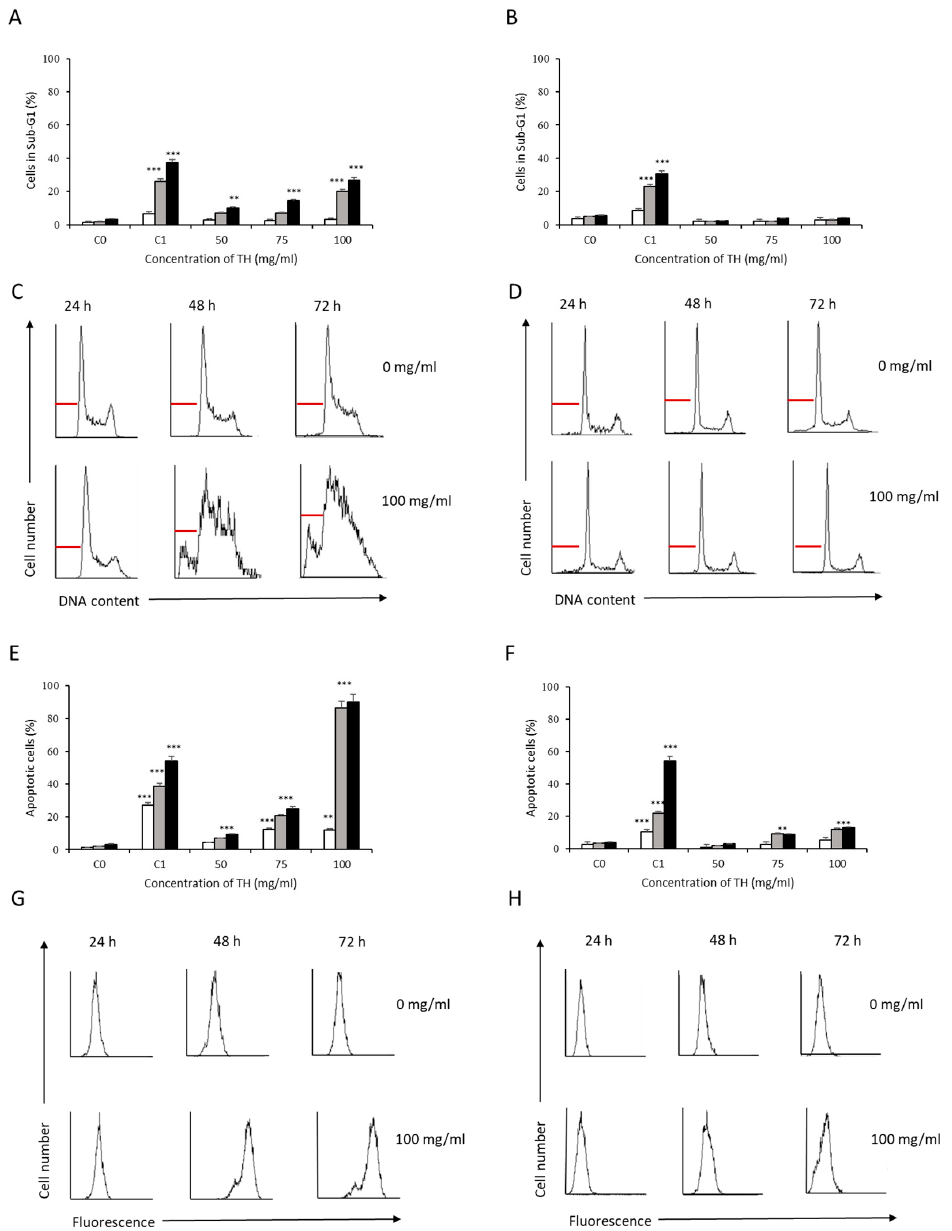
Figure 4. Effect of sample 1 (TH) on human liver cells apoptosis. The cell cycle was determined using flow cytometry. HepG2 ( A ) and WRL-68 ( B ) cells were treated with different doses of sample 1 (50, 75, and 100 mg/mL) for 24 ( □ ), 48 ( ■ ), and 72 h ( ■ ). Representative histograms of the cell cycle of HepG2 ( C ) and WRL-68 ( D ) cells are shown; the red line indicates the sub-G1 phase. The percentage of apoptosis was analyzed by flow cytometry using the TUNEL assay. HepG2 ( E ) and WRL-68 ( F ) cells were cultured with different doses of sample 1 (50, 75, and 100 mg/mL) for 24 ( □ ), 48 ( ■ ), and 72 h ( ■ ). Representative histograms of the fluorescence intensity in HepG2 ( G ) and WRL-68 ( H ) cells are presented. C 0 , untreated cells; C 1 , cells treated with etoposide (50 µM). Asterisks indicate a significant difference from the control (C 0 ). ** p ≤ 0.01,*** p ≤ 0.001. As shown in Figure 5, sample 6 (CH) induced apoptosis in HepG2 cells and did not affect WRL-68 cells. In HepG2 cells, the results confirmed an increase of cells in the sub-G1 phase (Figure 5A,C). In WRL-68 cells, no changes were produced in the cell cycle (Figure 5B,D). At 50 mg/mL, one-third of the population corresponded to apoptotic HepG2 cells